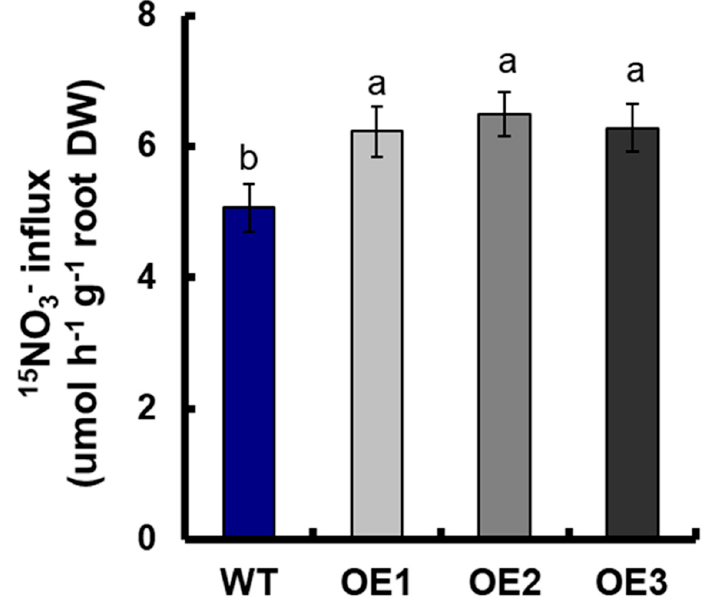
Figure 7. 15 NO 3– influx rate in roots of WT and OsNRT2.1 transgenic lines under 0.5-mM 15 NO 3– conditions with NPA treatment. WT and transgenic plants under 0.5-mM NO 3– with 1 µM of NPA treatment are shown. The plants were transferred to a quarter concentration of nutrient solution containing 0.5 mM of 15 NO 3– and 1 µM of NPA for 5 min. Error bars: SE ( n = 5). Significant differences between transgenic lines and WT are indicated by different letters ( p < 0.05, one-way ANOVA).